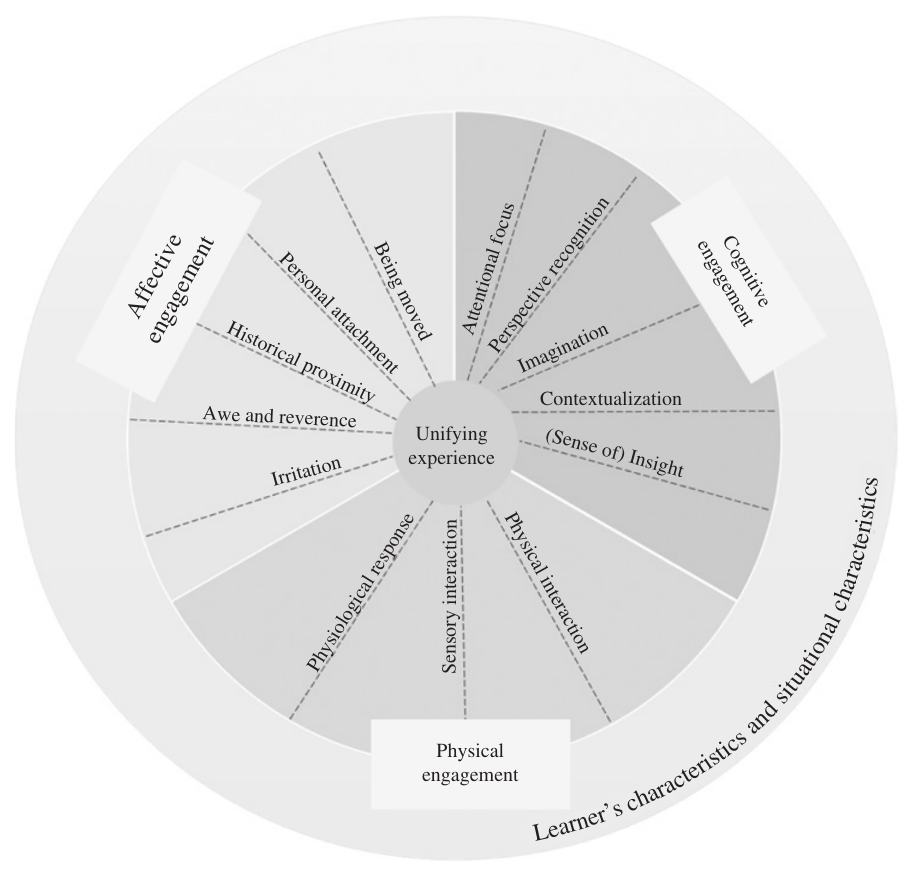
Figure 1: Conceptual framework of encountering complex historical sources Framework for encountering complex historical sources Cognitive